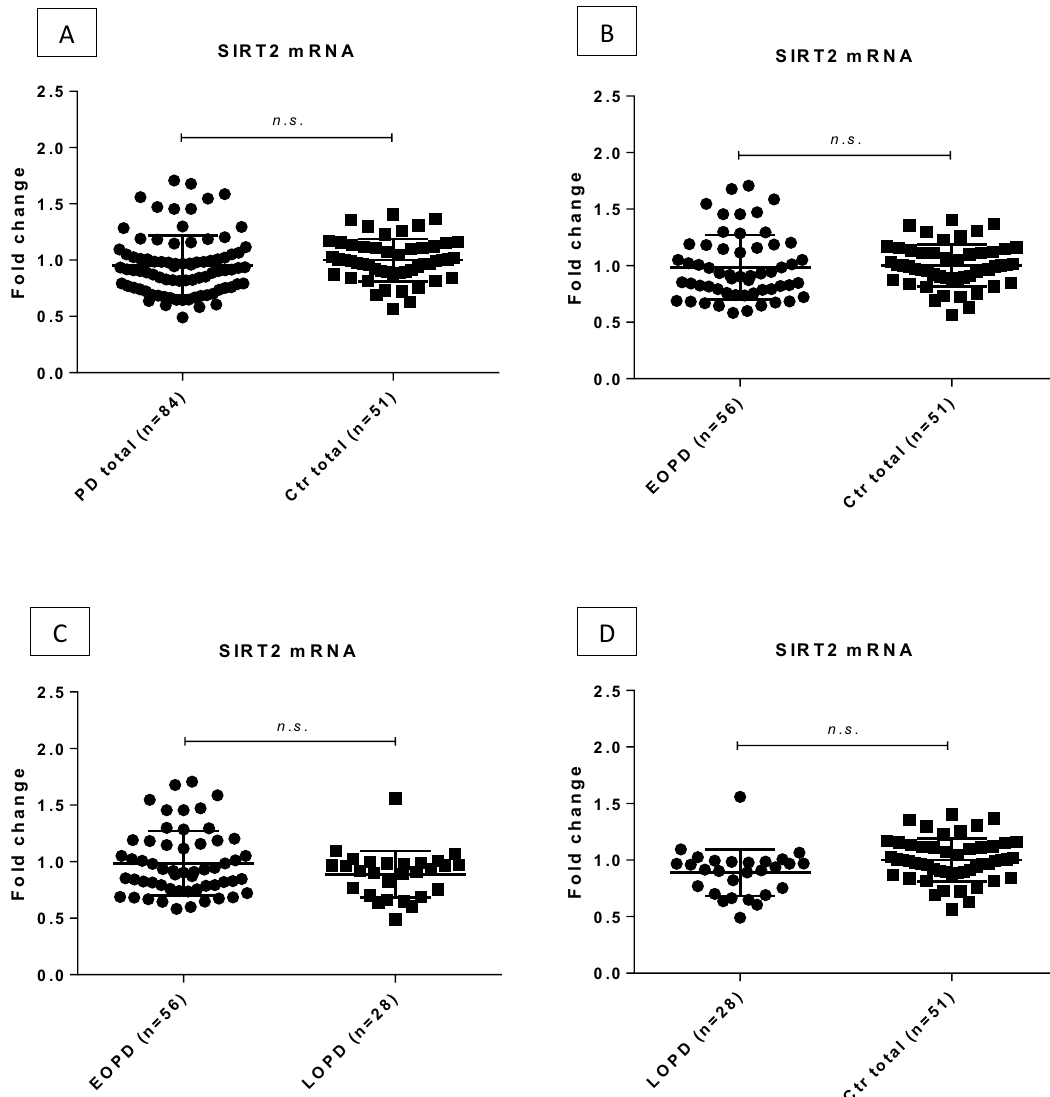
Figure 3. SIRT6 expression levels in peripheral blood of PD patients and controls. SIRT6 expression was significantly increased in PD patients compared to controls ( A ). The up-regulation was more pronounced in EOPD group compared to controls ( B ). No significant difference was detected between EOPD vs. LOPD ( C ) and LOPD vs . control group ( D ). Fold changes are shown with standard deviation. PD Parkinson’s disease, Ctrl control, EOPD early onset Parkinson’s disease, LOPD late onset Parkinson’s disease, n.s. non-significant; **p < 0.01 after FDR